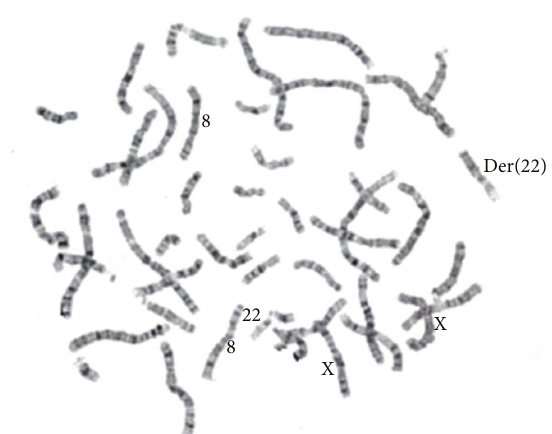
Figure 2: Micrograph of G-band metaphase chromosomes of the patient. Karyotype 46,XX der22t(8;22)(q22.1;p11.1)mat.